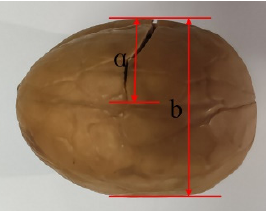
Figure 6. Crack length measurement in the horizontal direction, a is the crack length, b is the transverse diameter.